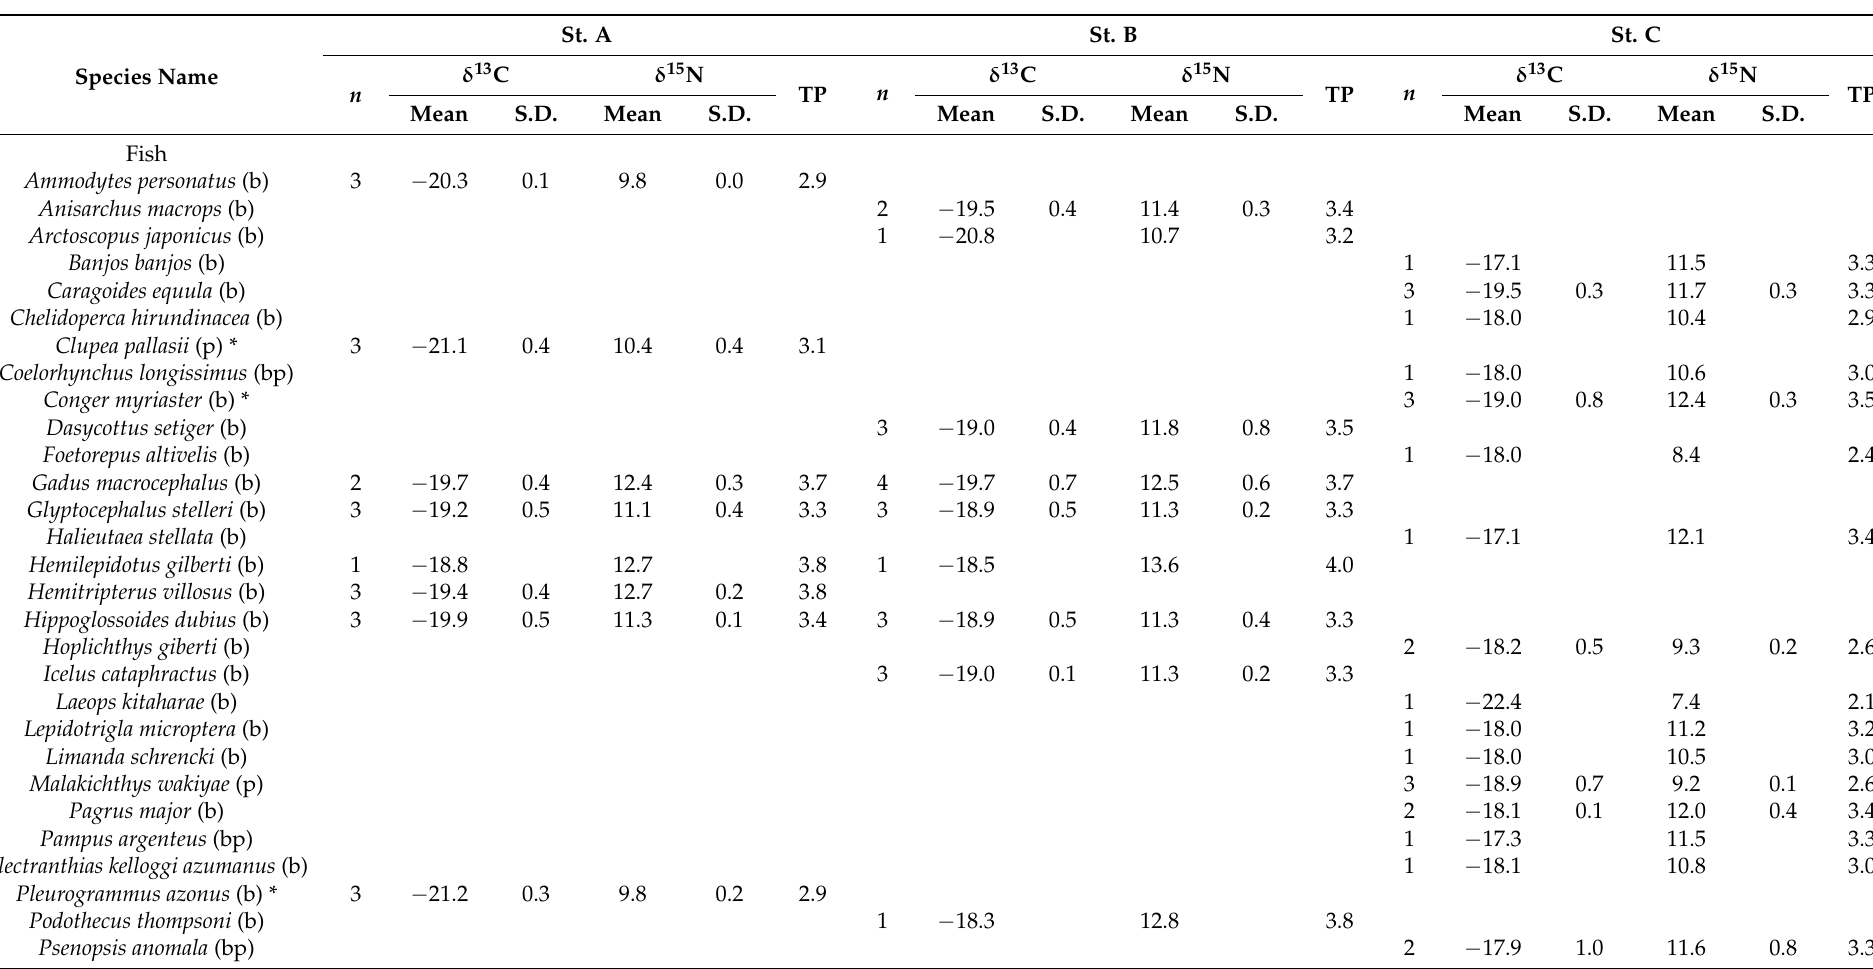
Table 4. δ 13 C and δ 15 N values and trophic position (TP) of fish consumers collected at the St. A, St. B, and St. C during May 2020. Lower case codes indicate feeding modes (b, benthic feeder; bp, benthopelagic feeder; p, pelagic feeder). The lipid-correction was applied for the δ 13 C of marked species (*). Data represent mean ± 1